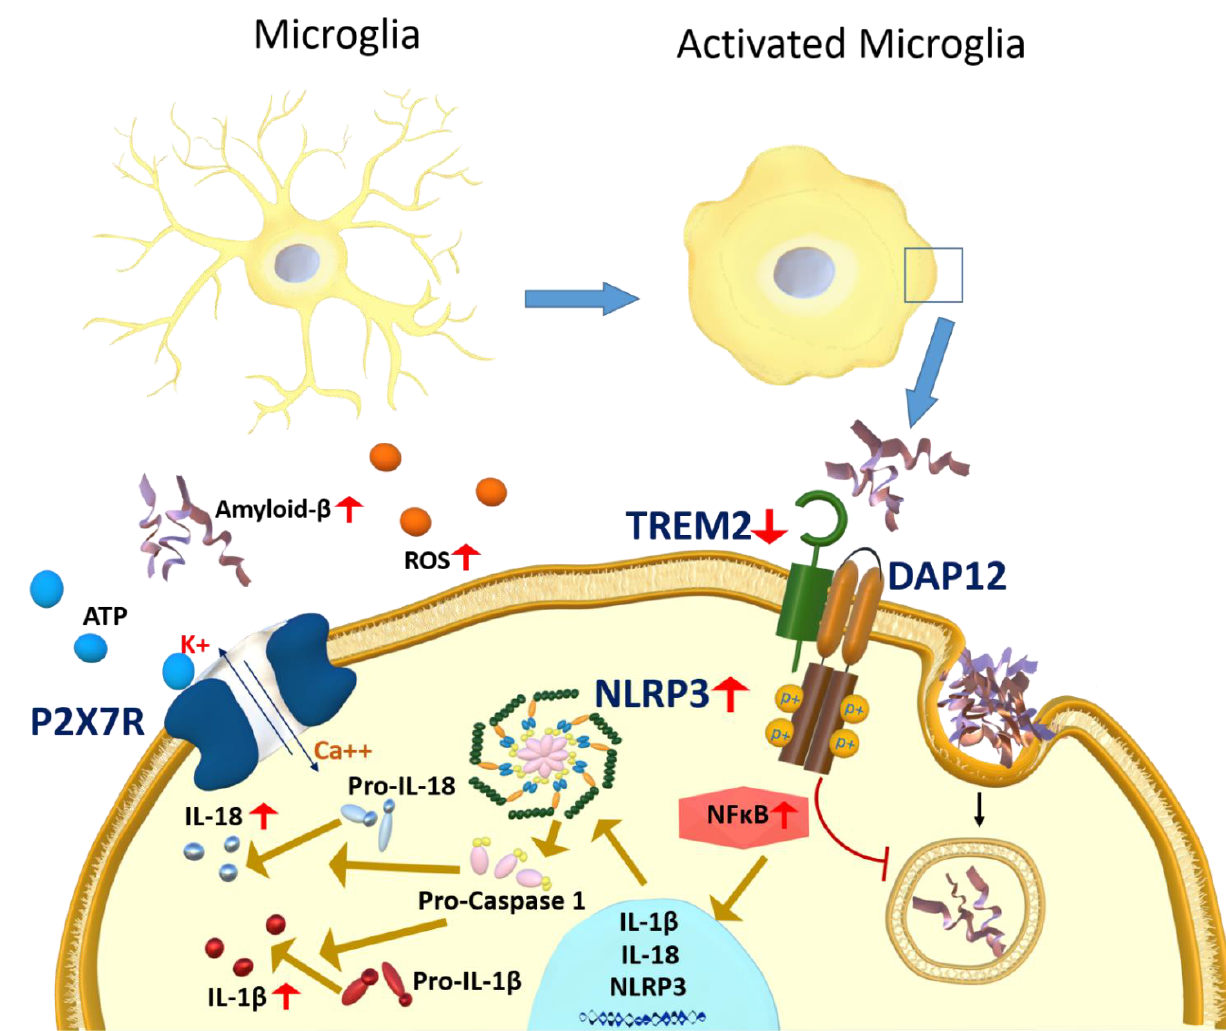
Figure 1. Microglia activation in AD. Neuroinflammation in AD is associated with microglia activa- tion that is mediated by increased Aβ, ROS, and ATP, which could activate P2X 7 R and downregulate TREM2. P2X7R activation would increase calcium influx, which leads to microglia activation and the release of inflammatory cytokines. In AD, reduced levels of TREM2 would impair A β phagocytosis by the microglia and thus increase A β brain parenchymal burden. Microglia activation is also associated with NF- κ B and NLRP3 inflammasomes activation, which would activate caspase-1 and the